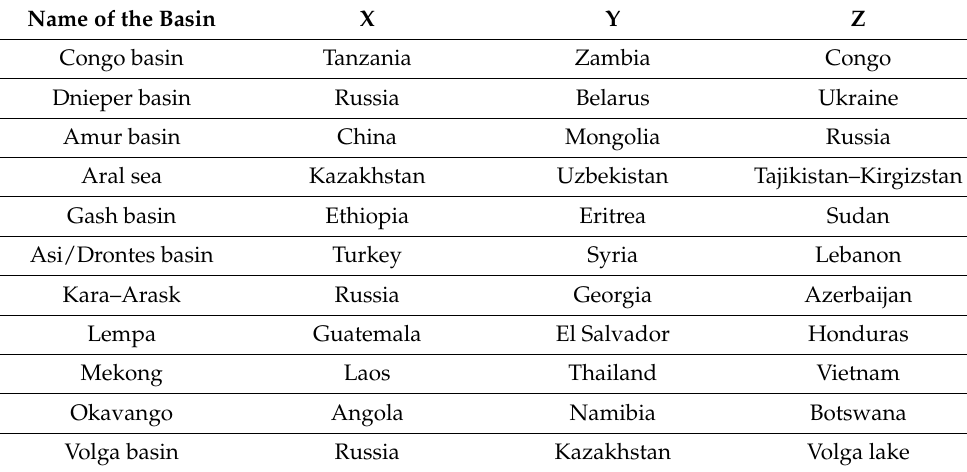
Table A4. Objective cases that can environmentally embrace HSA4.